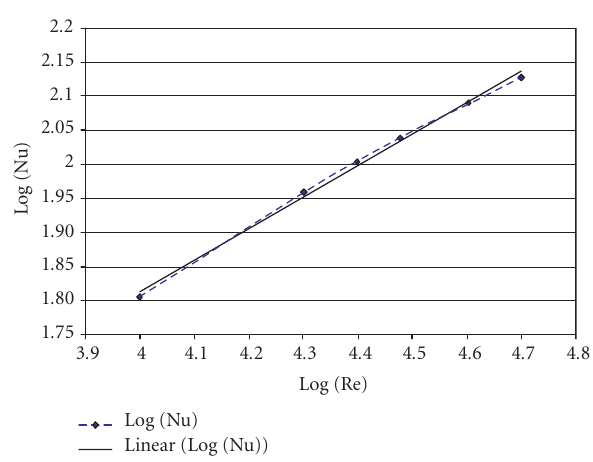
Figure 10: Variation of average Nusselt number with Reynolds number for a cooling channel at constant wall temperature and mass flow ratio ˙ m r = 1 / 1. ( y = 0 . 4616 × − 0 . 0331, R 2 = 0 . 9959, Nu = 0 . 92662 ∗ Re 0 . 4616 , or Nu = 1 . 04 ∗ Re 0 . 4616 ∗ Pr 1 / 3 . )